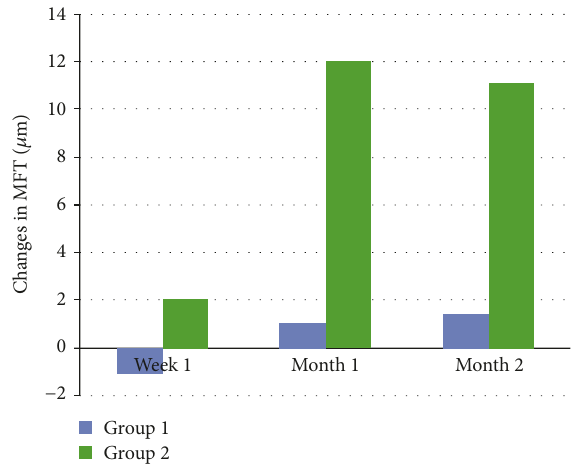
Figure 1: Changes in mean foveal thickness (MFT) in group 1 (ketorolac/steroid group) and group 2 (steroid group). The MFT was signi fi cantly lower in group 1 at week 1 and the fi rst and second months postoperatively ( P = 0 008 , P ≤ 0 001 , and P ≤ 0 001 ,